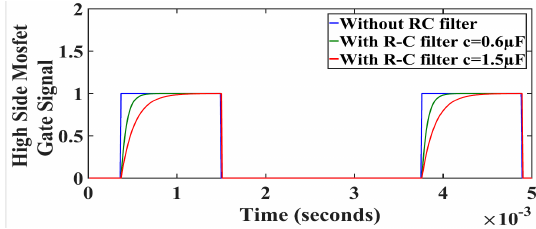
Figure 7. Gate control signal without R-C filter, with R-C filter for C = 0.6 µF, and with R-C filter for C = 1.5 µF.